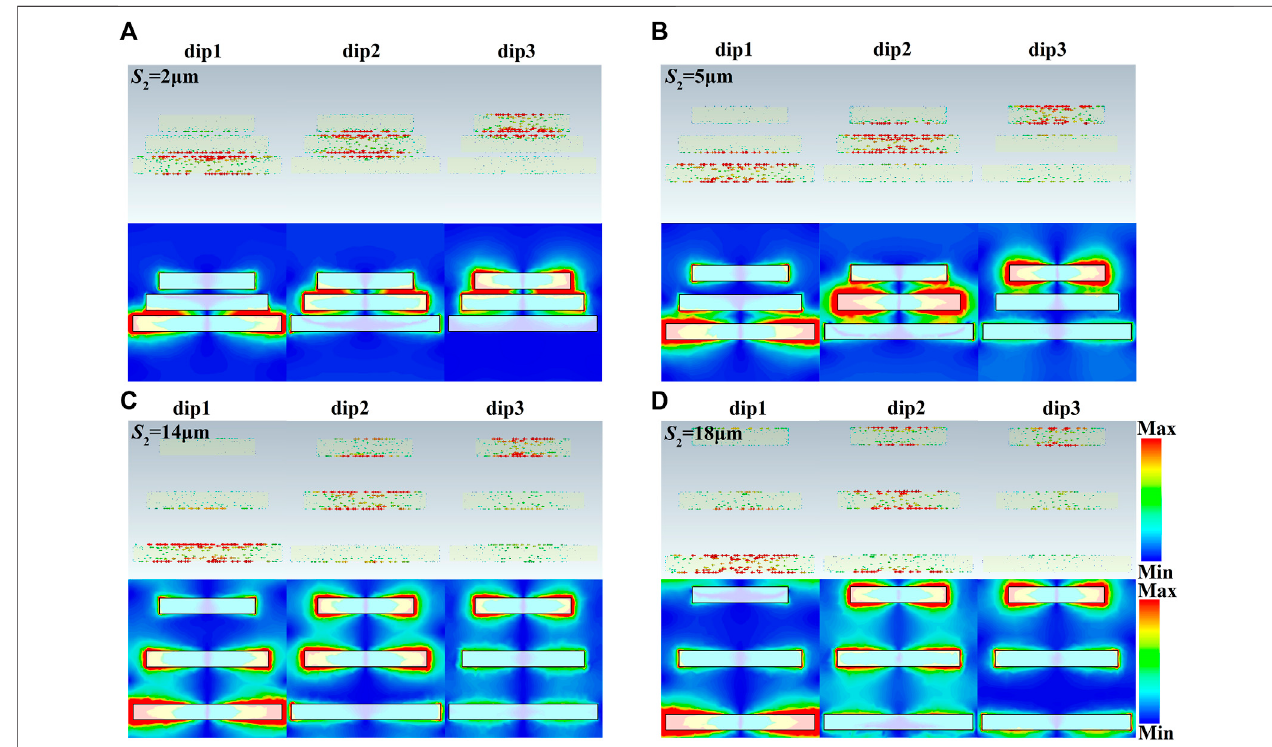
FIGURE 6 | Simulated surface currents and electric fi elds at the frequencies of three dips for S 2 of 2 (A) , 5 (B) , 14 (C) , and 18 μ m (D) , respectively.